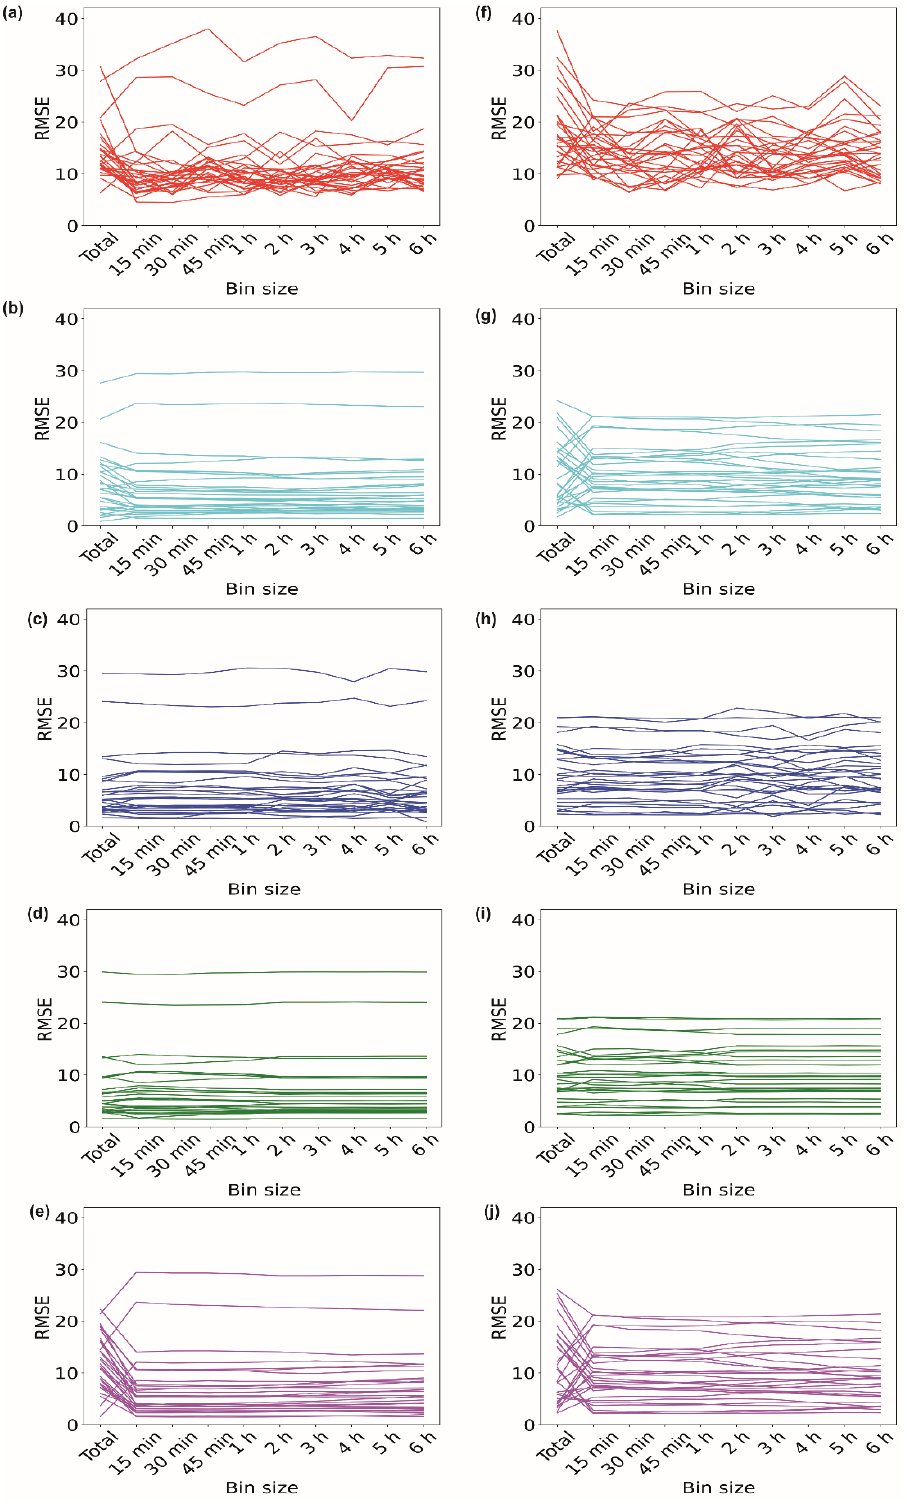
Figure 4. Imputation of 15 min of missing data. Variations in RMSE when data with different bin sizes were used for imputing missing data of ‘inactive’ period of 3–3:15 am using ( a ) EM, ( b ) II, ( c ) kNN, ( d ) RF, and ( e ) SI methods. Variations in RMSE when data with different bin sizes were used for imputing missing data of ‘active’ period of 3–3:15 pm using ( f ) EM, ( g ) II, ( h ) kNN, ( i ) RF, and ( j ) SI methods.